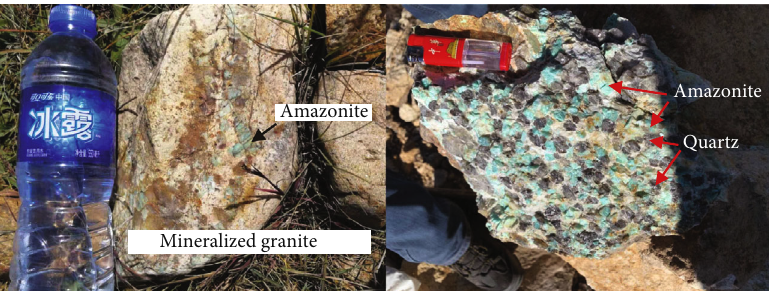
Figure 2: Ore types of the Zhaojinggou Ta-Nb deposit, showing that the ore mainly are massive ore including quartz (purple in color) and amazonite (blue in